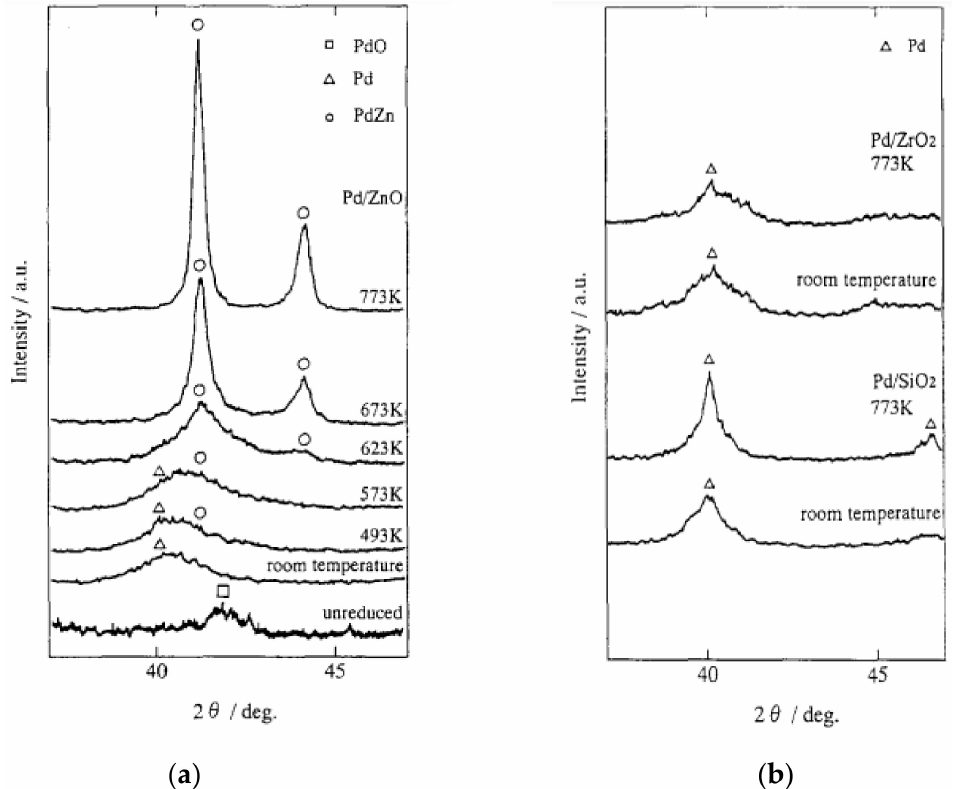
Figure 11. X-ray diffractogram of 10 wt.% Pd on: ( a ) ZnO; ( b ) ZrO 2 and SiO 2 , respectively. The temperatures of reducing treatment are given in each figure. There is no evidence of PdZn alloy for Pd/ZrO 2 and Pd/SiO 2 catalysts. (Adapted from [143], copyright 1995,